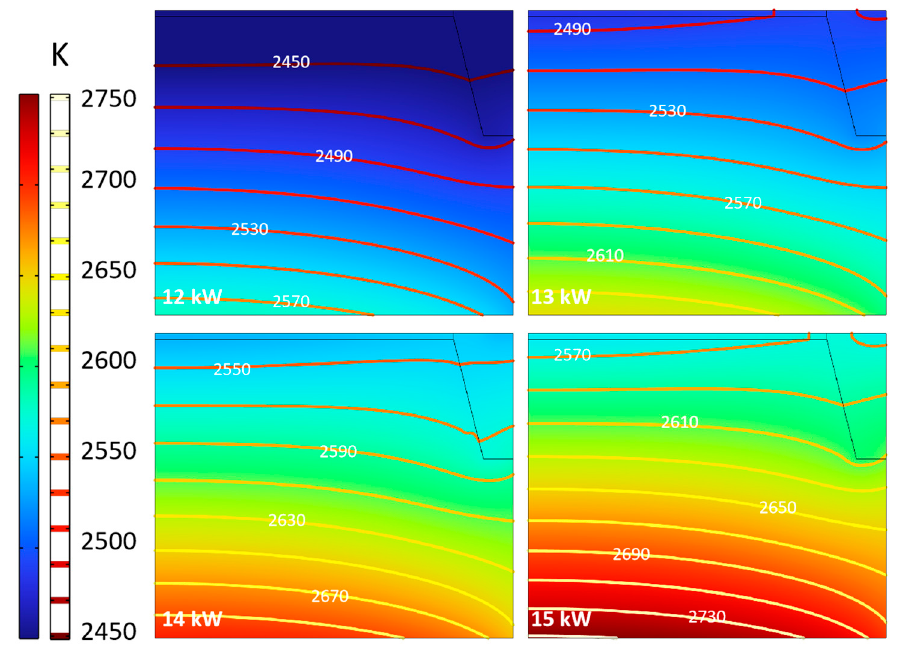
Figure 9. Temperature distribution in the chamber.